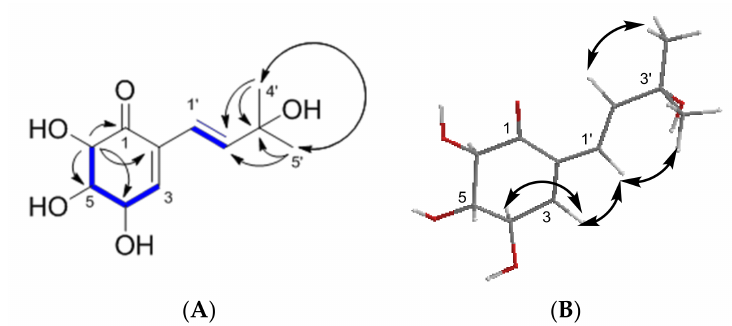
Figure 2. ( A ) Correlation spectroscopy (COSY) (in blue boldface), heteronuclear multiple-bond correlation (HMBC) (black arrows) and ( B ) Overhauser-effect spectroscopy (NOESY) (black arrows) of 1 .